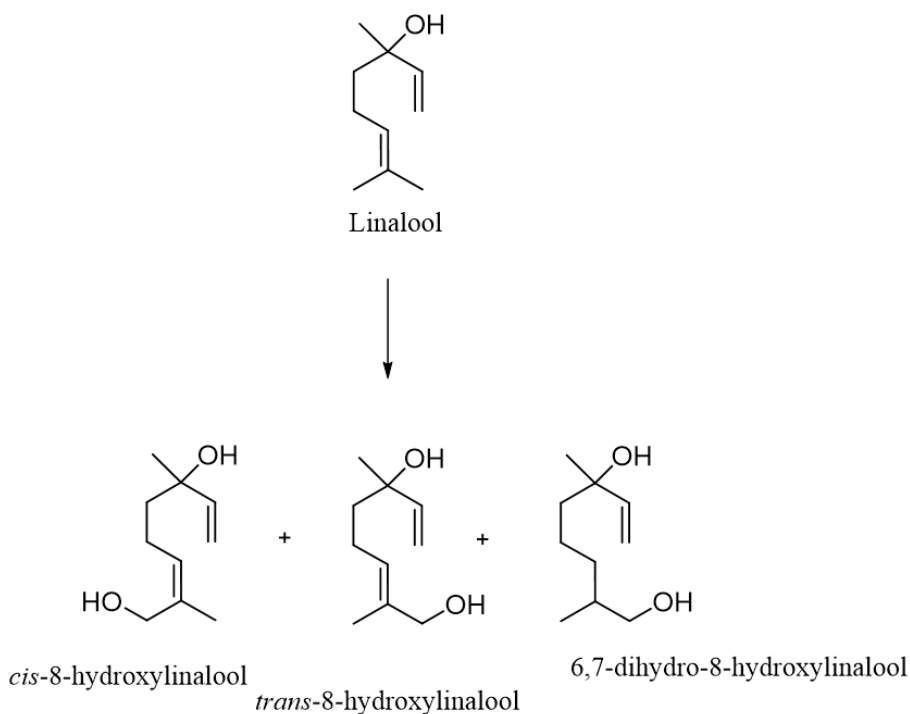
Molecules 2022 , 27 , x FOR PEER REVIEW 15 of 20 Scheme 6. Biotransformation of linalool by B. cinerea strains. The same derivative of linalool was also obtained when Nicotiana tabacum “Bright Yellow” tissue culture was used for the biotransformation of linalool. Callus tissues obtained from the plant stem were pre-cultured for 3–4 weeks in medium containing 2 ppm 2,4-dichlorophenoxyacetic acid and 2% sucrose. (3 R )-( − )-Linalool (20 mg per flask) was added to the grown culture (40–60 g per flask) and then shaken at 25 °C in the dark for 7 days. 8-Hydroxylinalool was obtained in a yield of 16.5% [89]. In another experiment, a suspension culture was used for the biotransformation